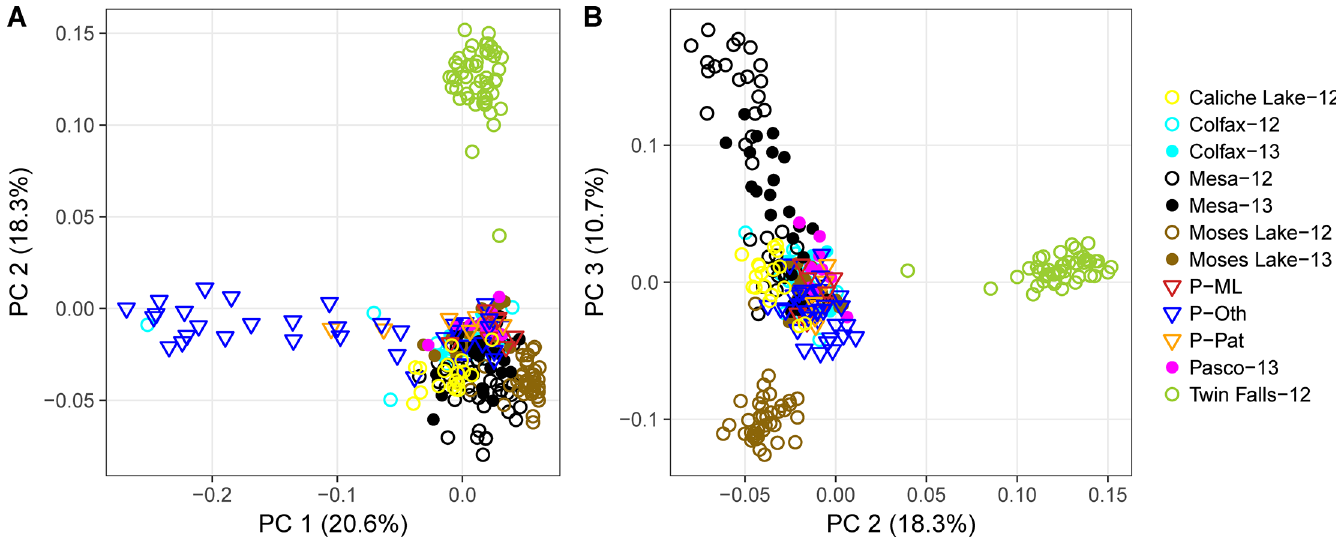
Fig 4. Principal component analysis (PCA) of genotypes of potato psyllids from nightshades and potatoes. (A). Principal component (PC) 1 and PC2. (B). PC2 and PC3. Psyllids were groupedby samplingsites (same color indicate same site), samplingyear (non-filledsymbol: 2012; filled symbol: 2013) and host plants (circle: nightshades, triangle: potatoes). Percentageaccountedfor overall genotypevariabilityof each PC was indicatedin the axis labels.